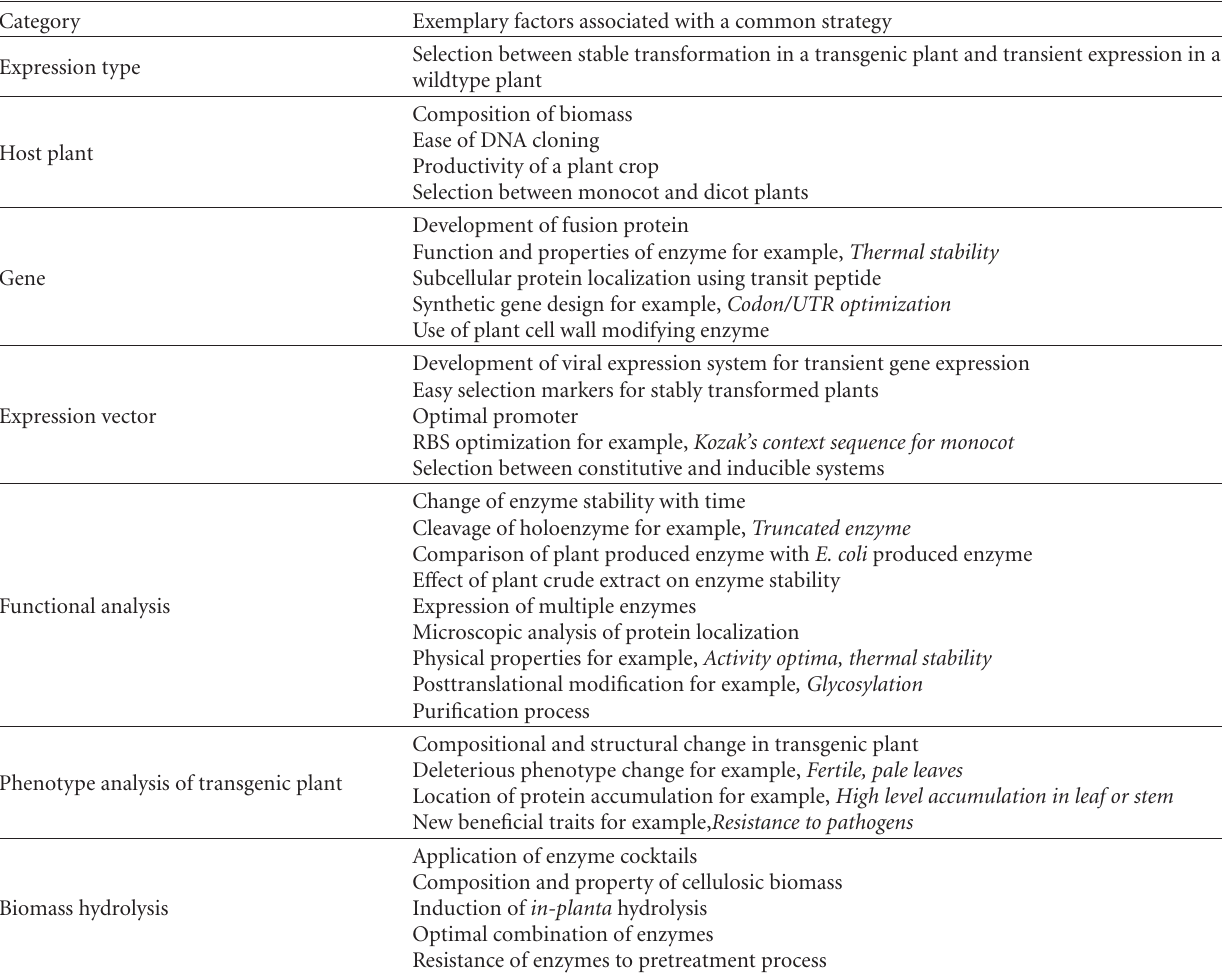
Table 2: Factors to consider in plant-based expression of plant cell wall degrading